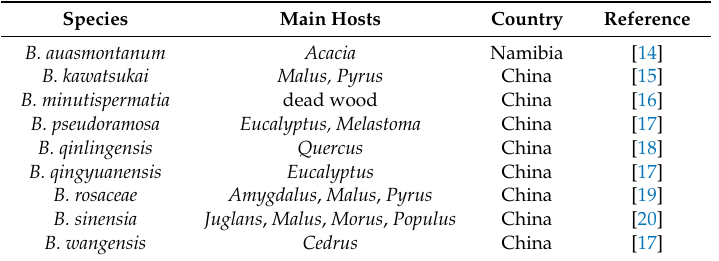
Table 1. Botryosphaeria species with Fusicoccum anamorph described after